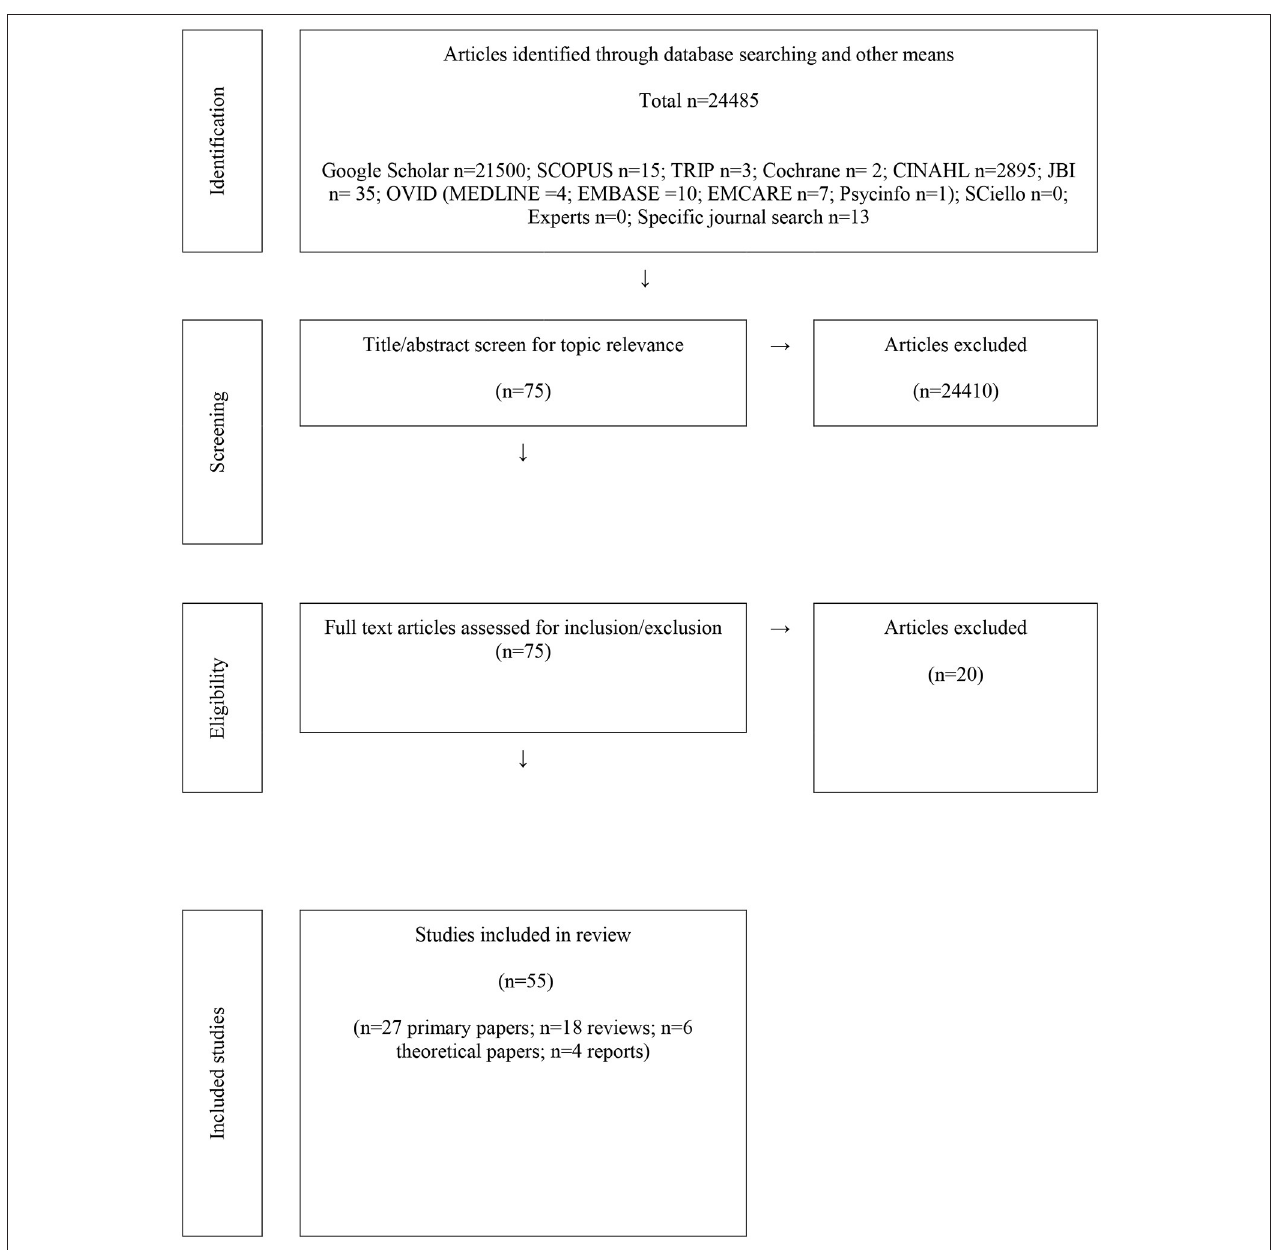
FIGURE 1 | Summary of process of total data through the